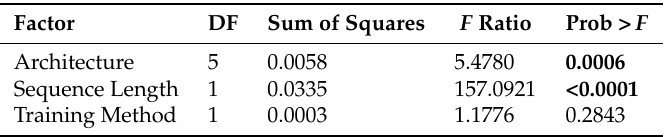
Table 6. Results of the 3-factor ANOVA evaluating the main effects of architecture, sequence length, and two training methods (cross-validated group method and 7-classifier ensemble method) on mean accuracy. Significant results are displayed in bold .